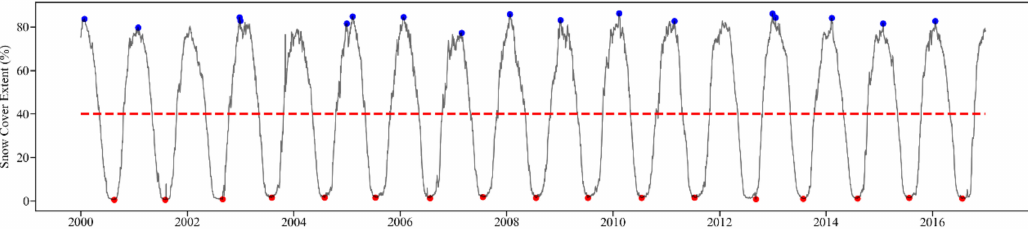
Figure 6. Daily variation of SCE in the study area from 2000 to 2016. The blue dots and red dots indicate the maximum and minimum SCE in every year,